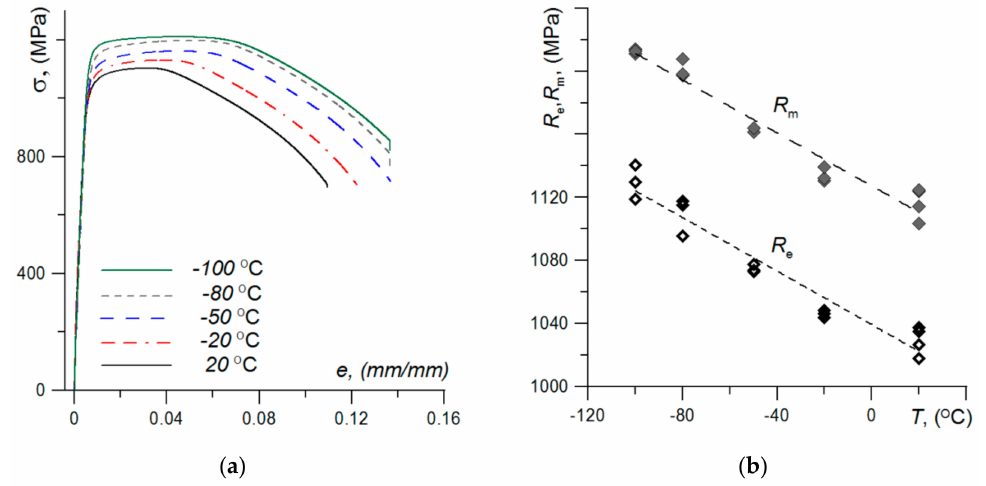
Figure 7. The tensile test results at reduced temperature: ( a ) diagrams of σ – e ; ( b ) change of R e and R m values with